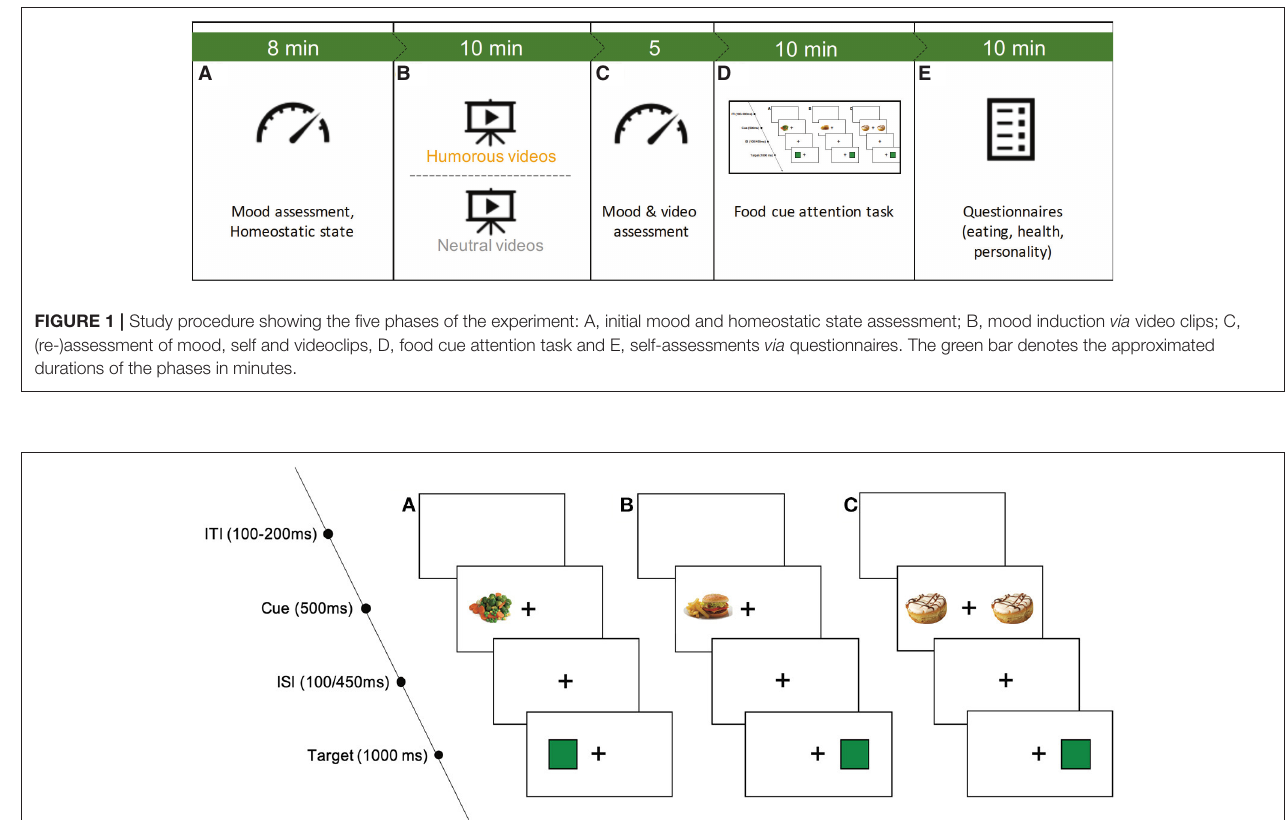
symptomatology. The sum of scores served as the dependent variable for both